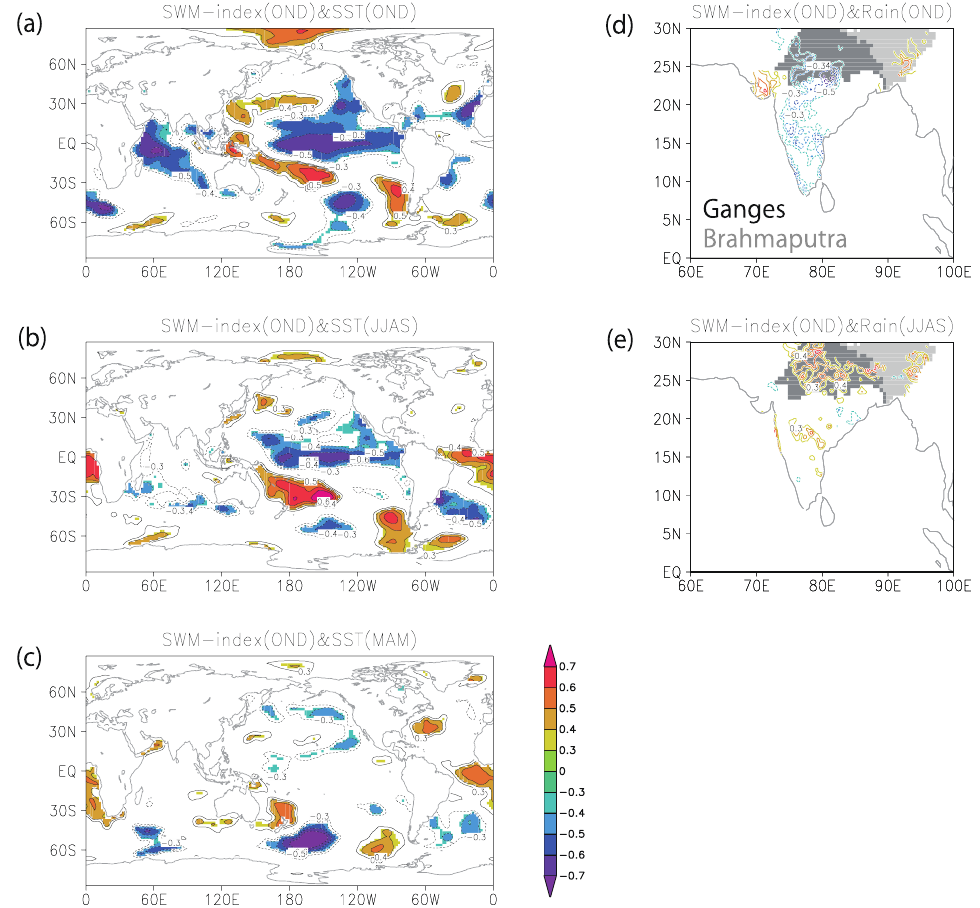
Figure 1. Climate precursors of fall SWM index over the north Bay of Bengal. Correlation maps between the October and December (OND) SWM index over the north BoB (20–23° N, 85–95° E) and ( a ) same-season OND SST anomaly, ( b ) one-season lead June–September (JJAS) SST anomaly, ( c ) two-season lead March–May (MAM) SST anomaly, ( d ) same-season OND rainfall anomaly, and ( e ) one-season lead JJAS rainfall anomaly. In ( a – c ), only areas above 90% significance are shaded. In ( d , e ), contour intervals are 0.1 (less than ± 0.3 are omitted).